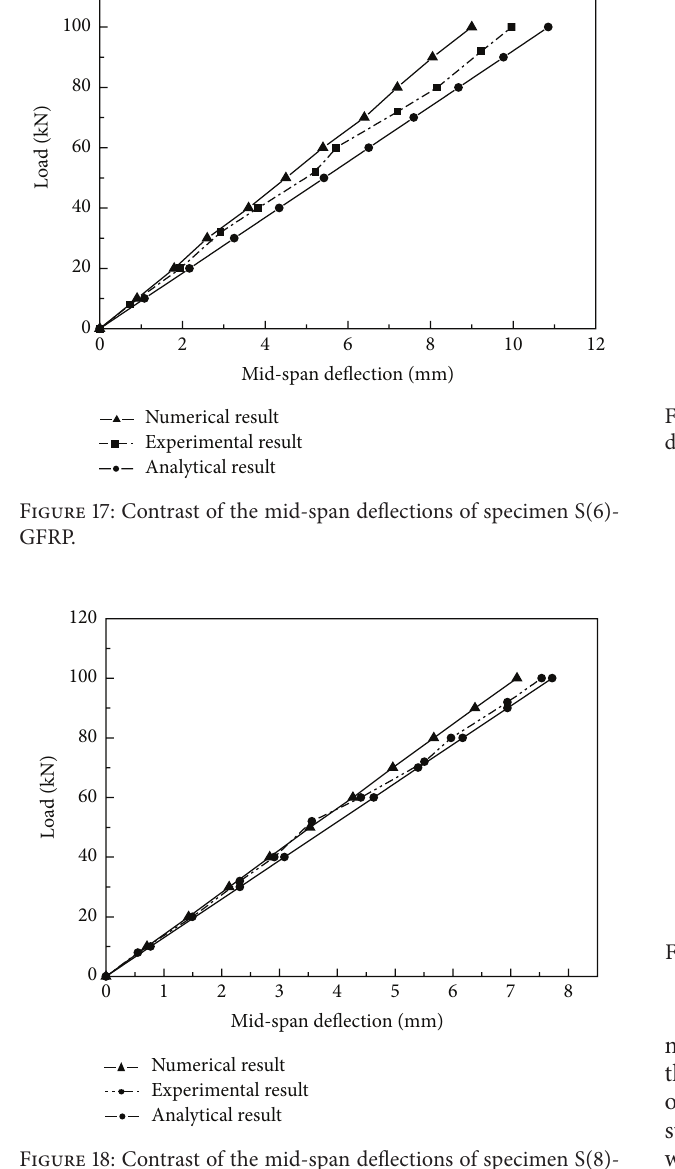
Figure 18: Contrast of the mid-span deflections of specimen S( 8 )- GFRP.